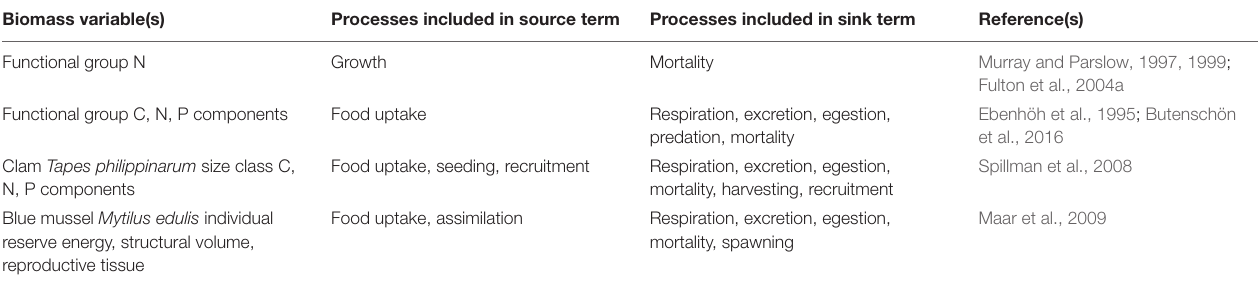
TABLE 1 | Examples of benthic fauna biomass models of different complexity. Biomass variable(s) Processes included in source term Processes included in sink